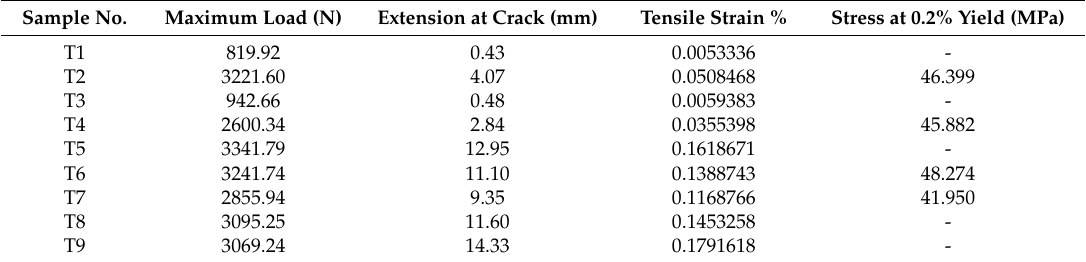
Figure 6. Force–extension curves of the failing results.